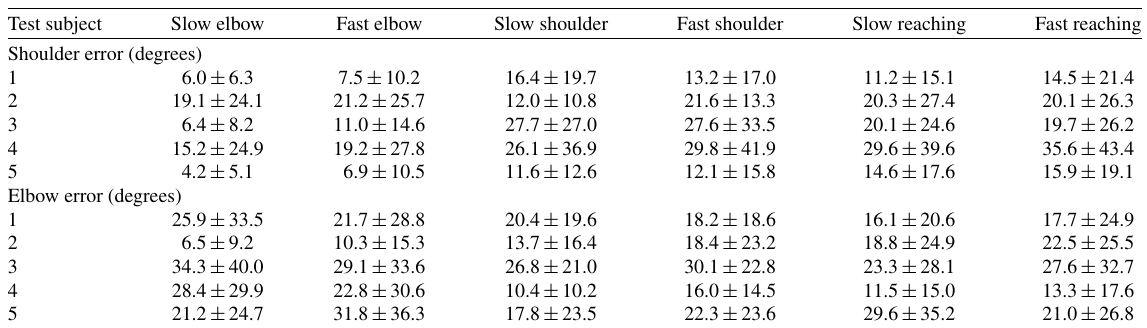
Table 4 interval of 100ms.